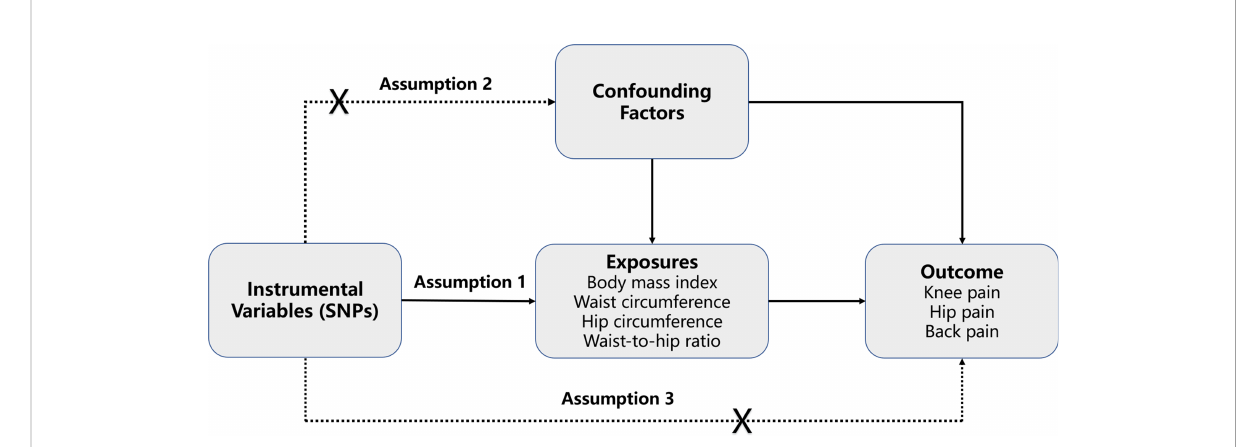
FIGURE 1 The diagram of Mendelian randomization study. Three assumptions are required. Firstly, the genetic variants should be closely related to the exposures. Secondly, the genetic variants are supposed to be independent of confounding factors. Thirdly, the effects of the genetic variants on outcomes are only mediated by the exposures. SNPs, single-nucleotide